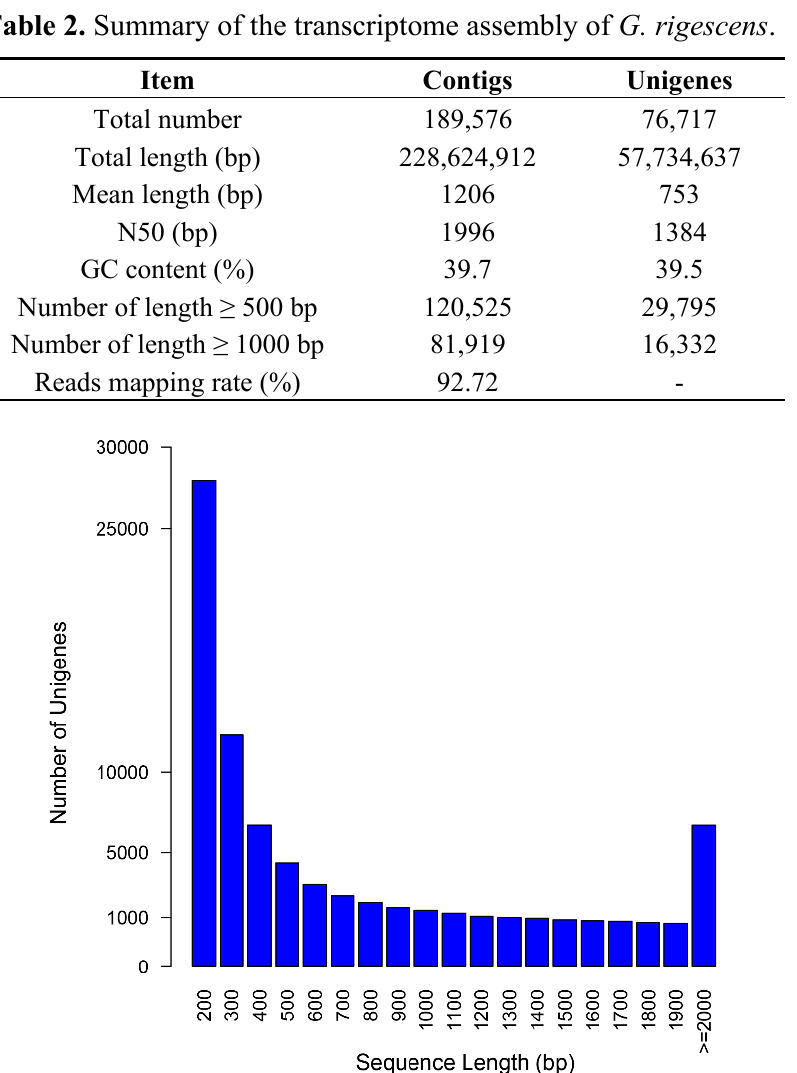
Figure 1. Length distribution frequency of the unigenes in G. rigescens